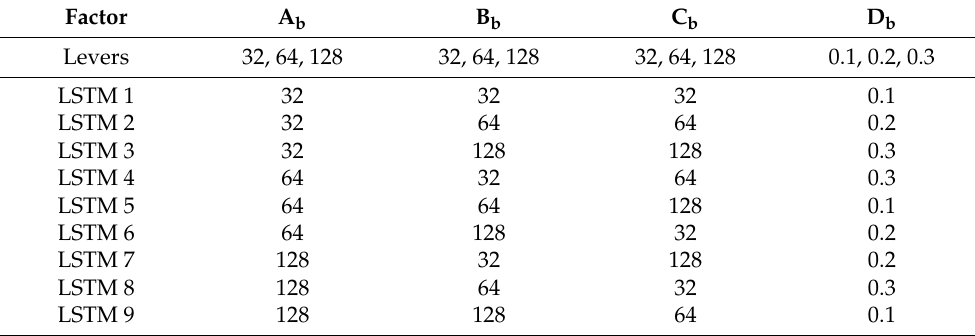
Table 4. The results of an orthogonal design experiment for the hyperparameter of LSTM model. Factor A b B b Factor Levers